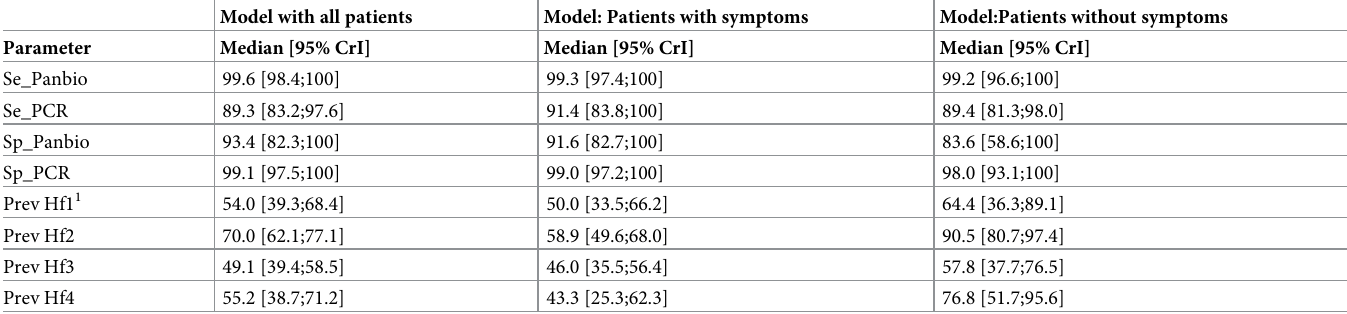
Table 3. Performance of test kits using all model of BLCM, Addis Ababa, Ethiopia,